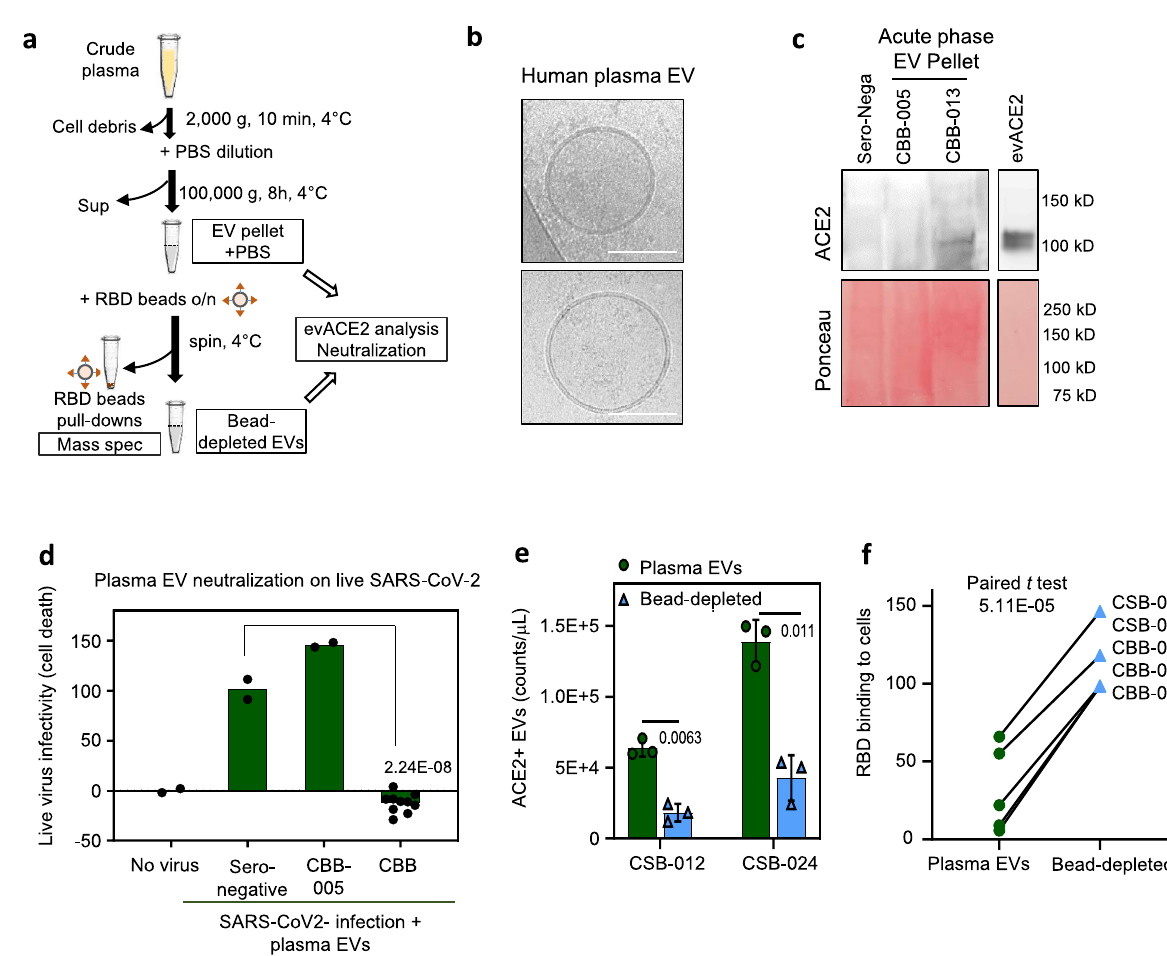
Fig. 3 evACE2 in patient plasma neutralizes SARS-CoV-2. a Schematic depiction of plasma EV ultracentrifugation and RBD-bead based depletion. b Cryo- EM images of human EV pellets isolated from acute phase COVID-19 plasma (bar = 100 nm). c Immunoblots of plasma EV pellets (sero-negative and COVID-19 acute phase patients CBB-005 and -013) for ACE2 and loading control of protein staining with Ponceau). Laemmli buffer was used for lysis ( N = 1 experiment). d ACE2 + EV pellets from acute phase patients 007, 008, 009, 012, and 013 (CBB) ( n = 2 biological replicates each) blocked SARS- CoV-2 infection-induced death of Vero-6 cells whereas the sero-negative control ( n = 2 biological replicates) and CBB-005 (no detectable ACE2) ( n = 2 biological replicates) did not show neutralization effects. One-tail t test, **** p = 2.24E − 08 shown as compared to sero-negative. e , f Levels of ACE2 + EV counts ( n = 3 biological replicates) in plasma EVs (green) and bead-depleted EVs (light blue). One-tail paired t test, * p = 0.011 and ** p = 0.0063 (data are presented as mean values ± SD) ( e ) and altered neutralization effects on RBD – host cell binding ( f ) of the COVID-19 plasma EV pellets prior to and